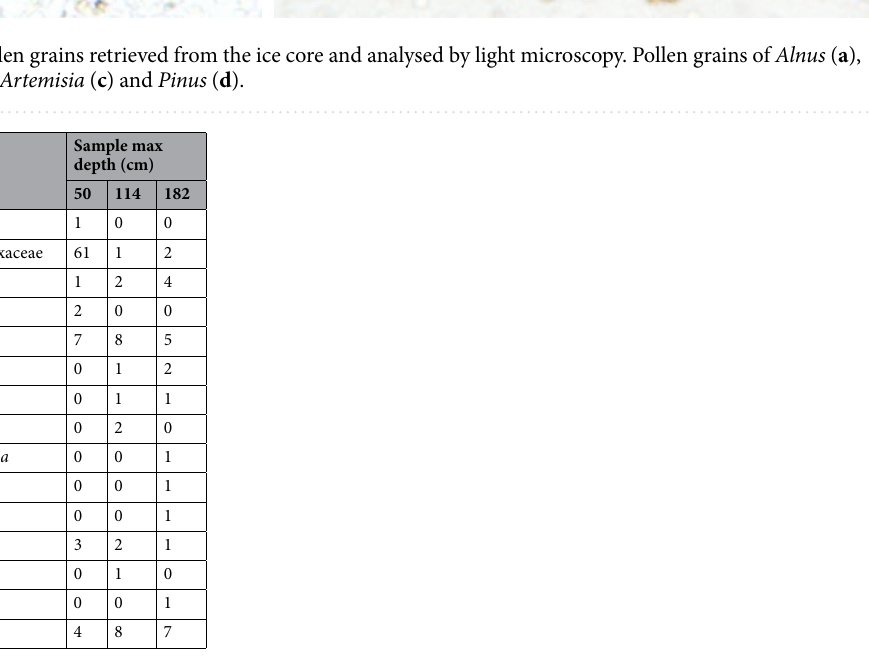
Table 1. Taxonomic assignment and counts from palynological analyses of three random 10-cm samples from Adamello glacier core. Figures in the table are the number of pollen grains detected for each taxon in the corresponding sample. Column headings show the relative depth of samples from the surface firn